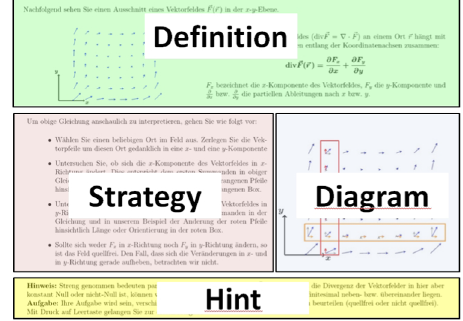
FIG. 3. Instruction page (with visual cues) with AOIs.